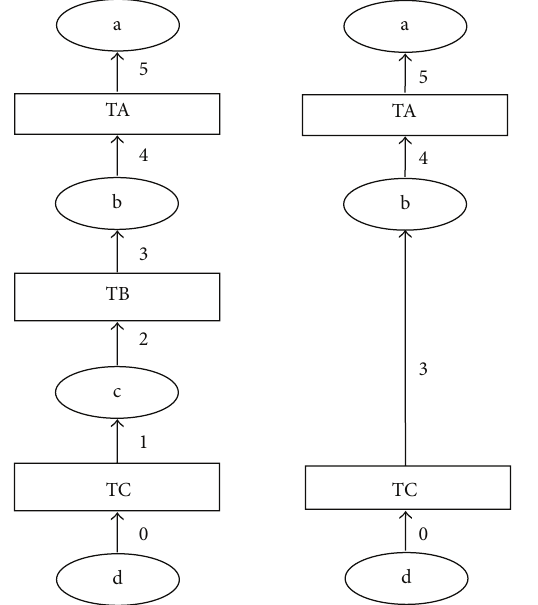
Figure 6: Reduction of sequence structure model fragment.